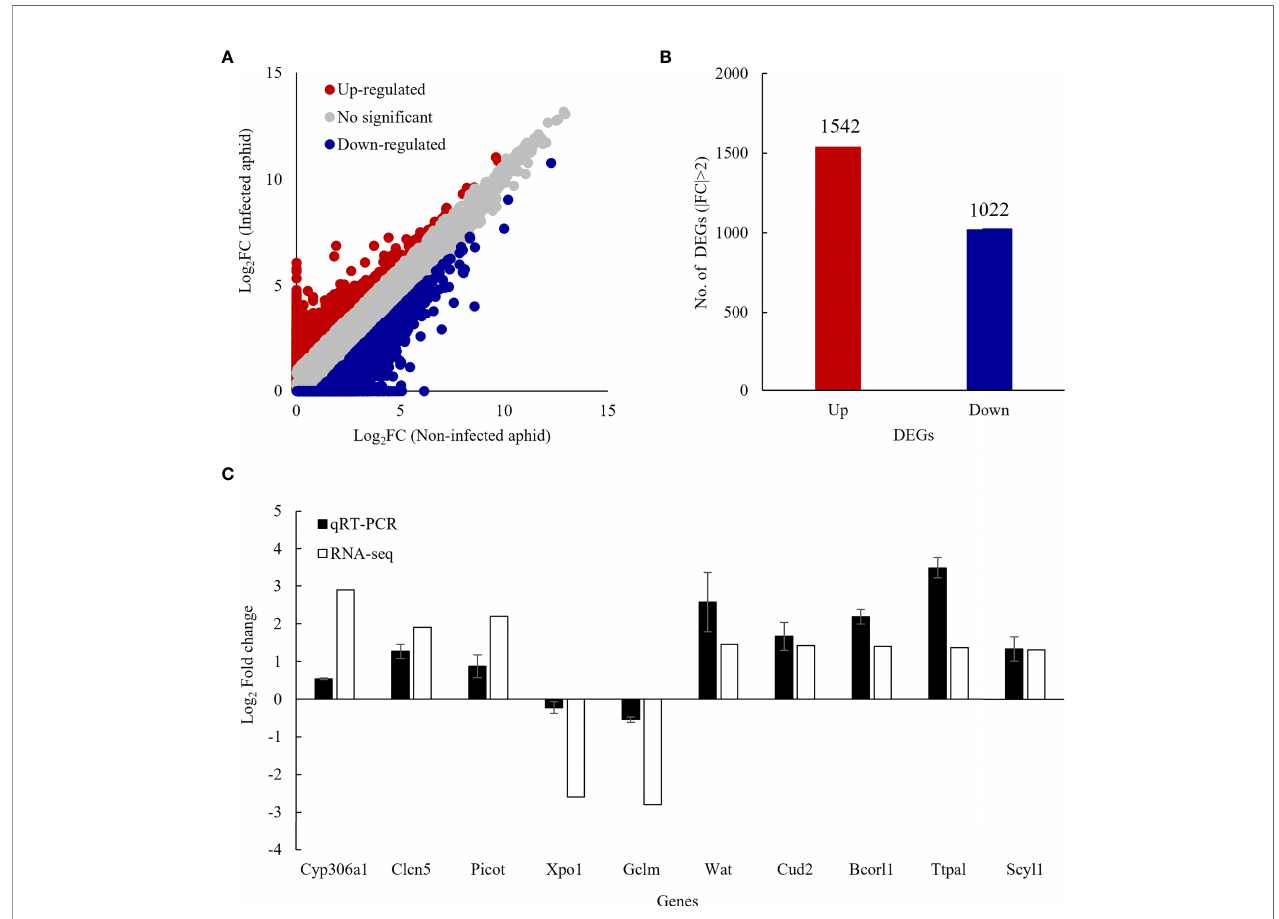
FIGURE 2 | Differentially expressed genes (DEGs) of infected coon aphids. (A) Scatter plot comparing log2 ratios of TPM expression values of non-infected and JEF- 544-infected aphids, (B) Number of DEGs in JEF-544-infected aphids (|FC|>2), (C) Validation of RNA-seq analysis using qRT-PCR. CYP306a1, cytochrome P450 306a1; Clen5, H(+)/Cl ( – ) exchange transporter 5; Picot, putative inorganic phosphate cotransporter; Xpo1, exportin-1; Gclm, glutamate-cysteine ligase regulatory subunit; Wat, fatty acyl-CoA reductase wat; Cud2, endocuticle structural glycoprotein SgAbd-2; Bcorl1, BCL-6 corepressor-like protein 1; Ttpal, alpha-tocopherol transfer protein; Scyl1, N-terminal